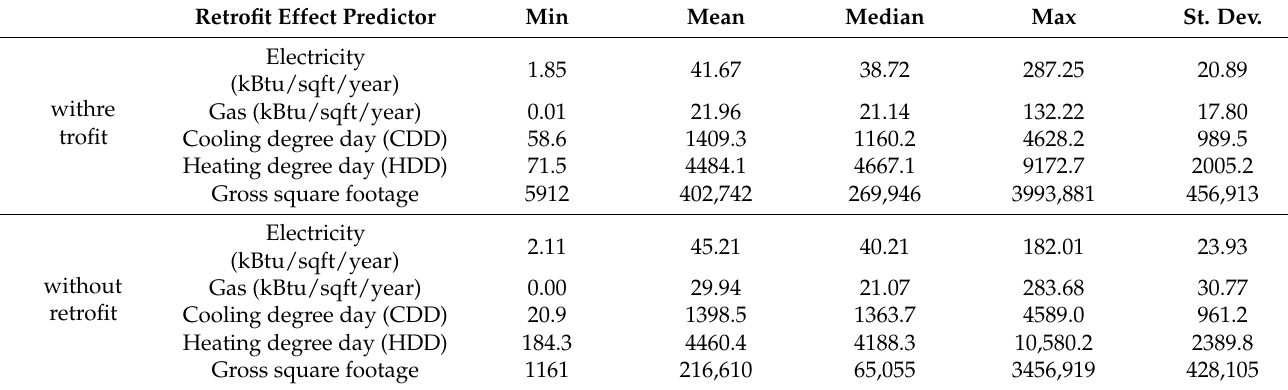
Table 3. Summary of the pre-retrofit characteristics of the retrofitted buildings and the un-retrofitted buildings. Retrofit Effect